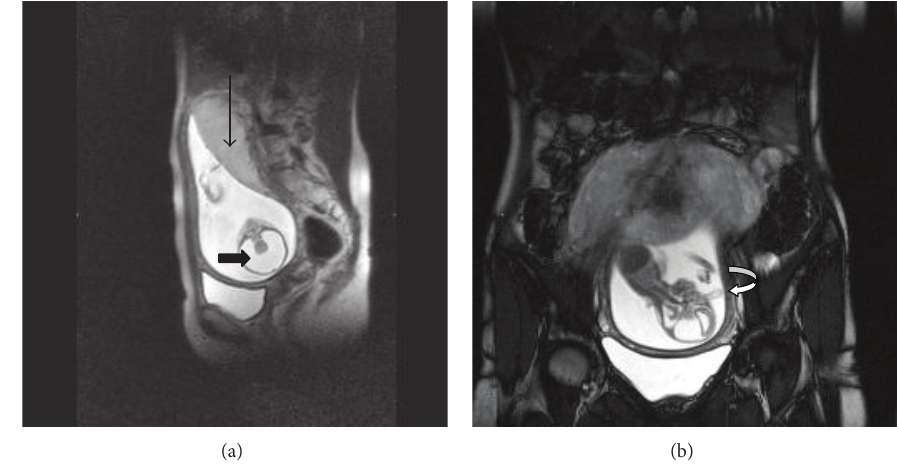
Figure 2: (a) T2 weighted image in the sagittal plane showing fused thalami and large monoventricle (short black arrow). Placenta is seen in the fundus (long black arrow). (b) T2 weighted image in the coronal plane showing the proboscis (curved black arrow). The brain stem and the spinal cord appear